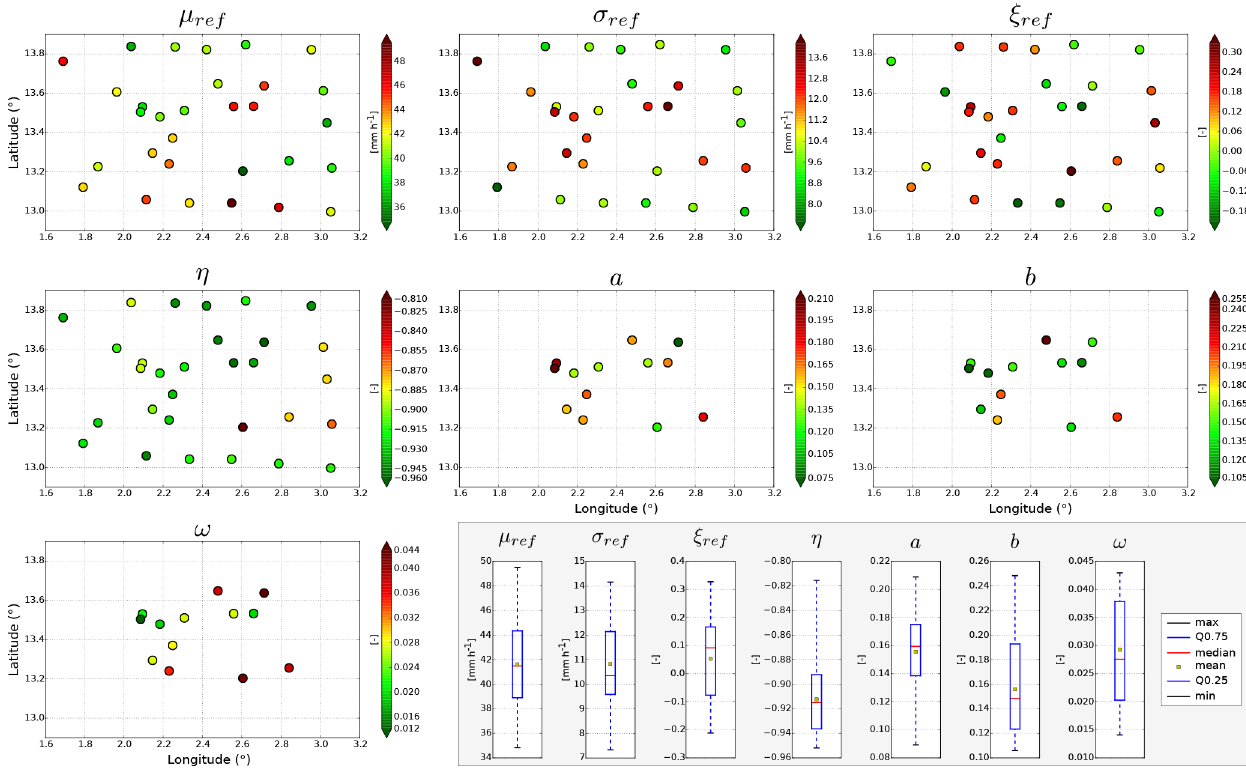
Figure 5. Map of the obtained IDF parameters ( η , µ ref , σ ref , and ξ ref fitted on the 30 rain gauge samples) and IDAF parameters ( η , µ ref , σ ref , ξ ref , a , b , and ω fitted on the 13 CR samples). The grey box shows box plots of the parameter values obtained at the different rain